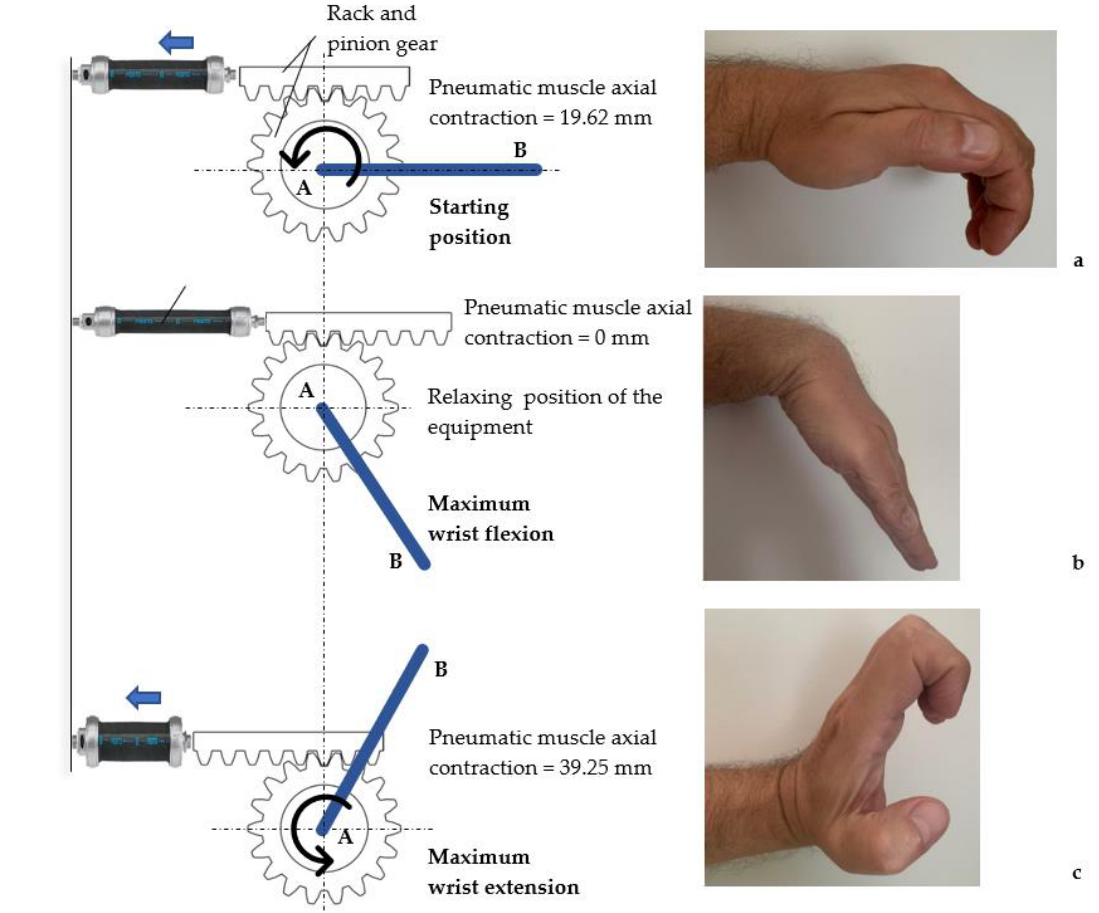
Figure 13. Positions of lever AB while the pneumatic muscle is charged with air: ( a ) Starting position; ( b ) Maximum wrist flexion; (c) Maximum wrist extension.